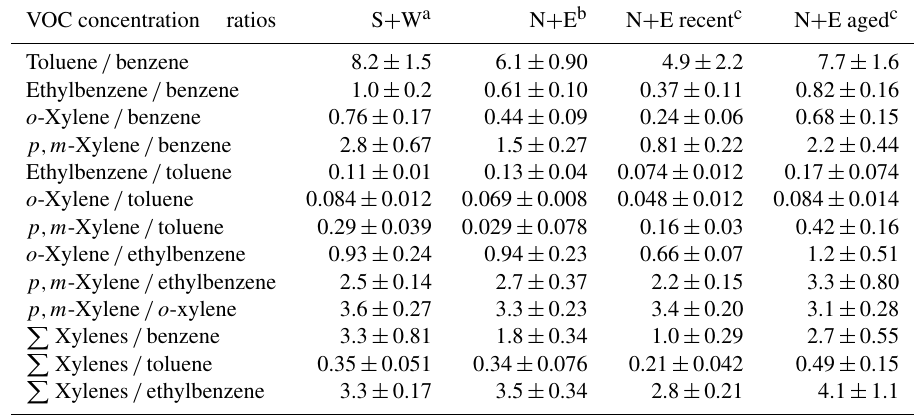
a Average ratio for data with winds dominantly from southern or western sectors. Only data points for which the wind direction was within ± 45 ◦ of the dominant wind direction during at least 80% of the sampling time are included. The number of data points is between 14 and 20. The uncertainty stated is the standard error of the mean. b Average ratios for data with winds dominantly from northern or eastern sectors are included. Only data points for which the wind direction was within ± 45 ◦ of the dominant wind direction during at least 80% of the sampling time are included. The number of data points is between 15 and 20. The uncertainty stated is the standard error of the mean. c Data for the N + E sector filtered based on R [OH]d t determined from the p,m- xylene carbon isotope ratio. Aged refers to samples with R [OH]d t > 0 at the 99% confidence limit. The confidence limit was calculated from the uncertainty of the isotope ratio of emissions, the measurement uncertainty and the uncertainty of the KIE. Recent represents samples with R [OH]d t below this limit. The values given are the average ratios and the standard error of the mean. The number of data points for recent is five; for aged there are between seven and nine